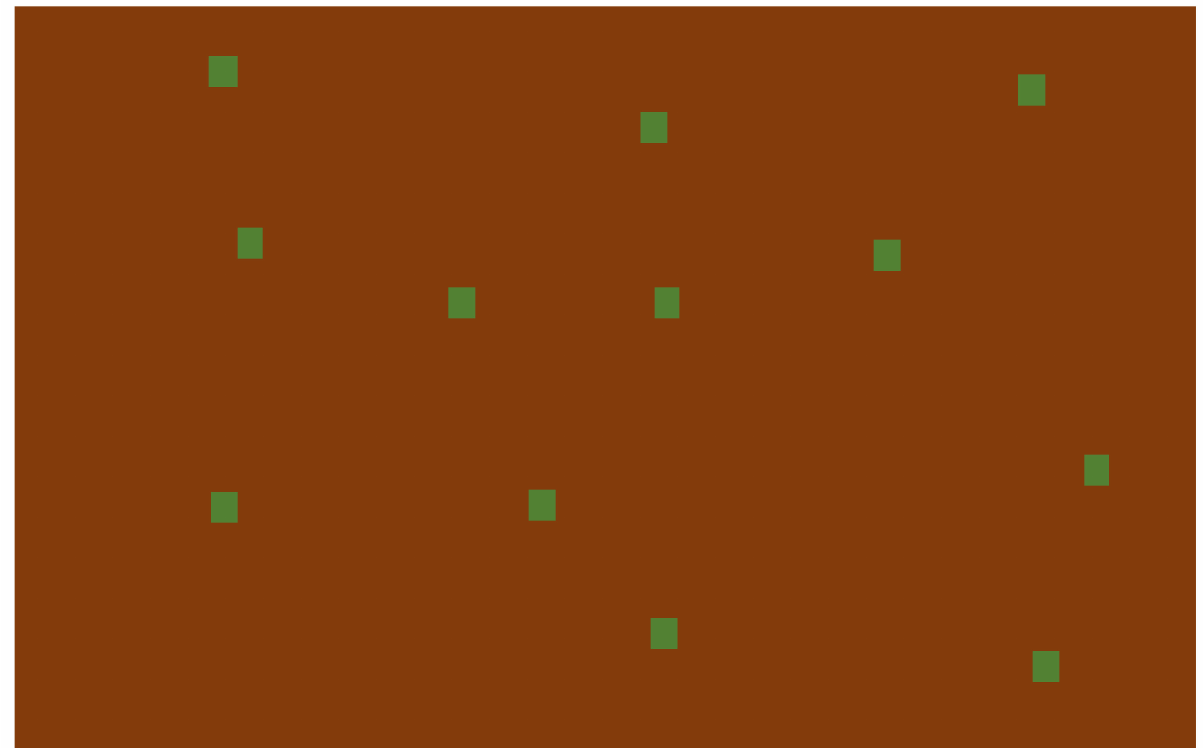
Figure 4. Draft of spot spraying, single plants inside a crop field